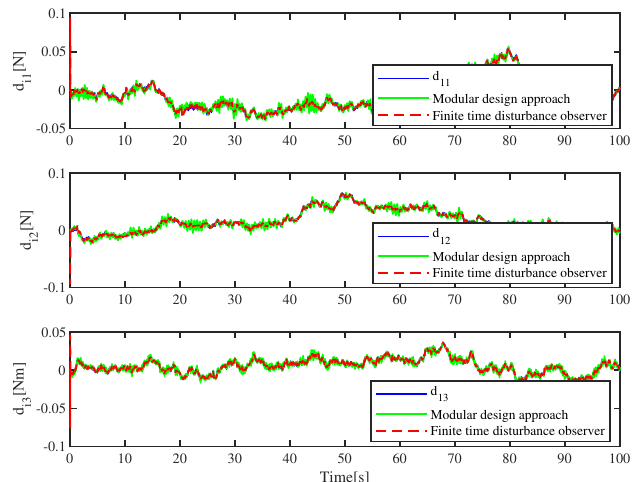
Figure 13. The time-varying environmental disturbances value and estimates obtained by using modular design approach and finite time disturbance